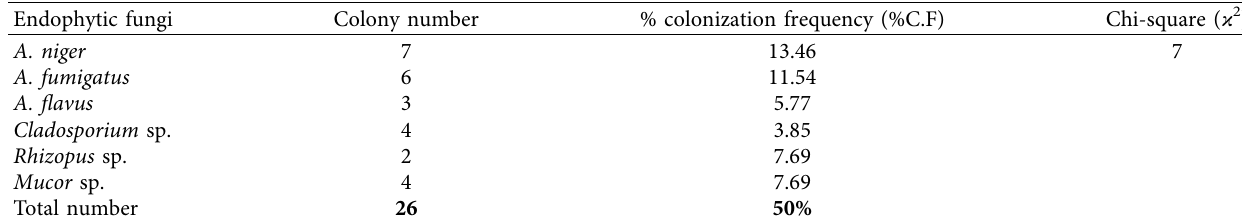
Table 1: Endophytic fungi isolated from Ziziphus spina leaves and colonization